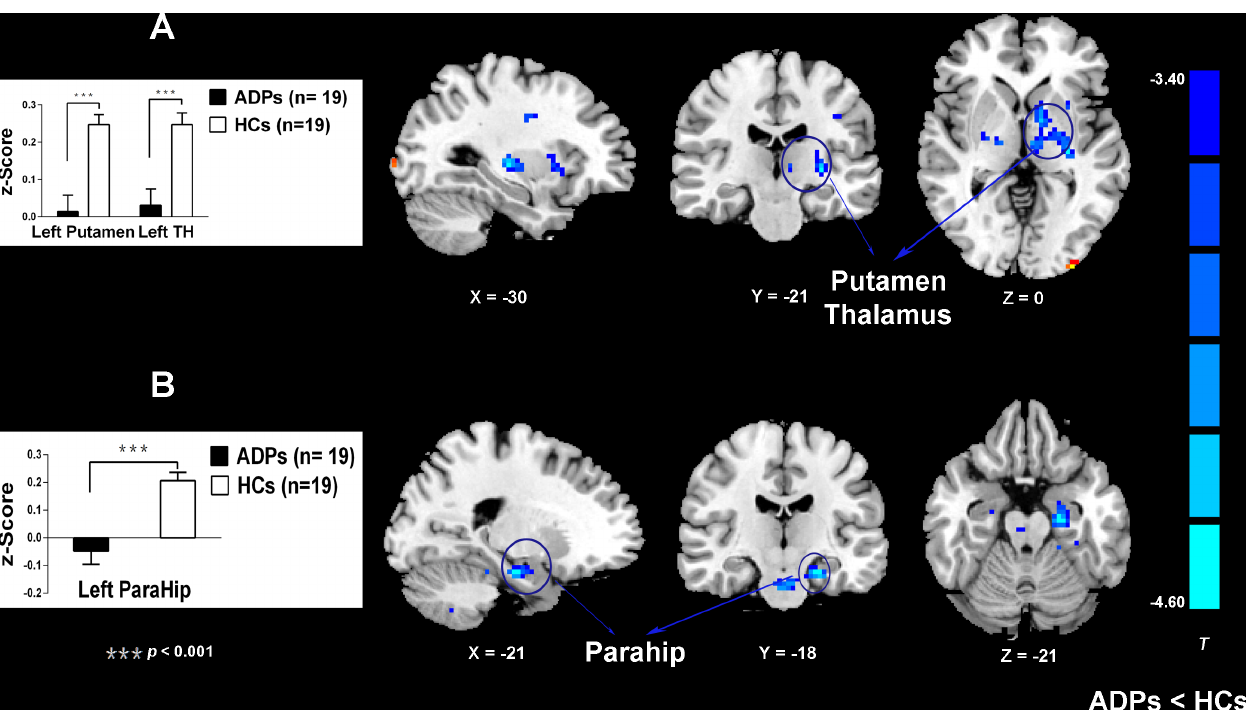
Fig 3. Group differences of rsFC existed between the seeds and the cluster location. Brain regions showed group differences include the thalamus, the putamen and the ParaHip. (A, B) Mean rsFC z scores were shown for ADPs and HCs. The ADPs showed weaker functional connectivity in reward network. Abbreviations: TH, thalamus; ParaHip, parahippocampal gyrus; ADPs, alcohol dependent patients; HCs, healthy controls.